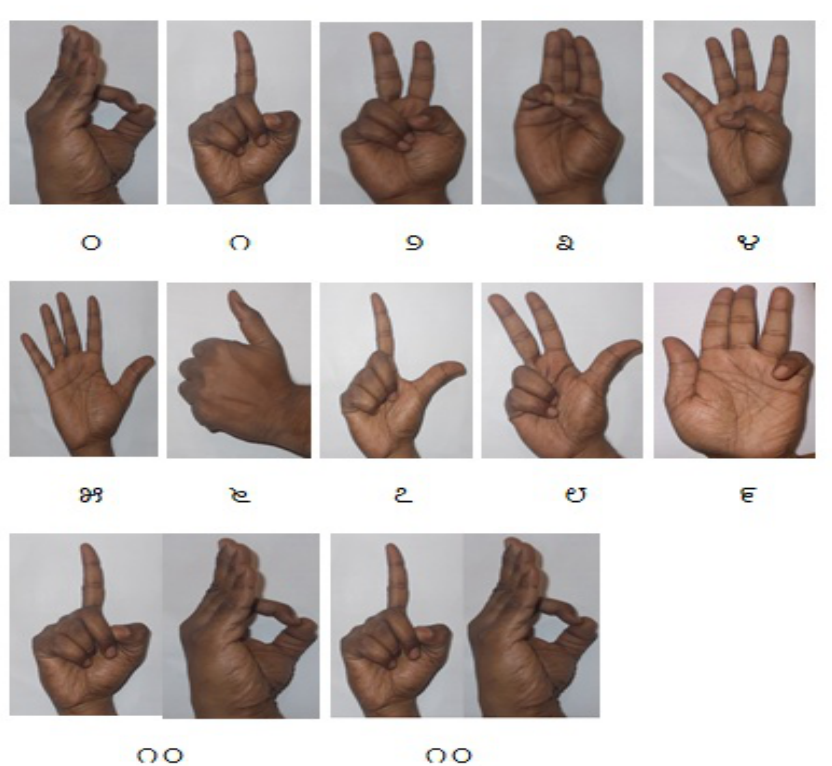
Fig. 3. Shows Sign symbol of numbers from 0 to